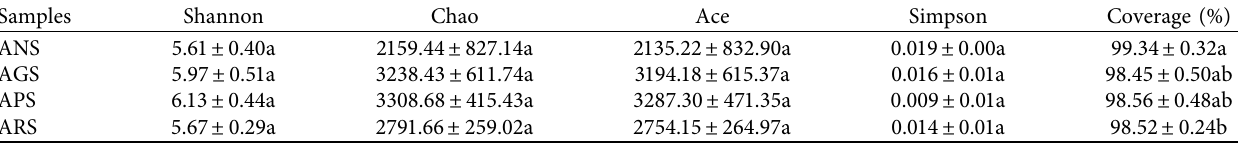
Table 8: Effects of bryophytes on bacterial community diversity index in mine waste slag